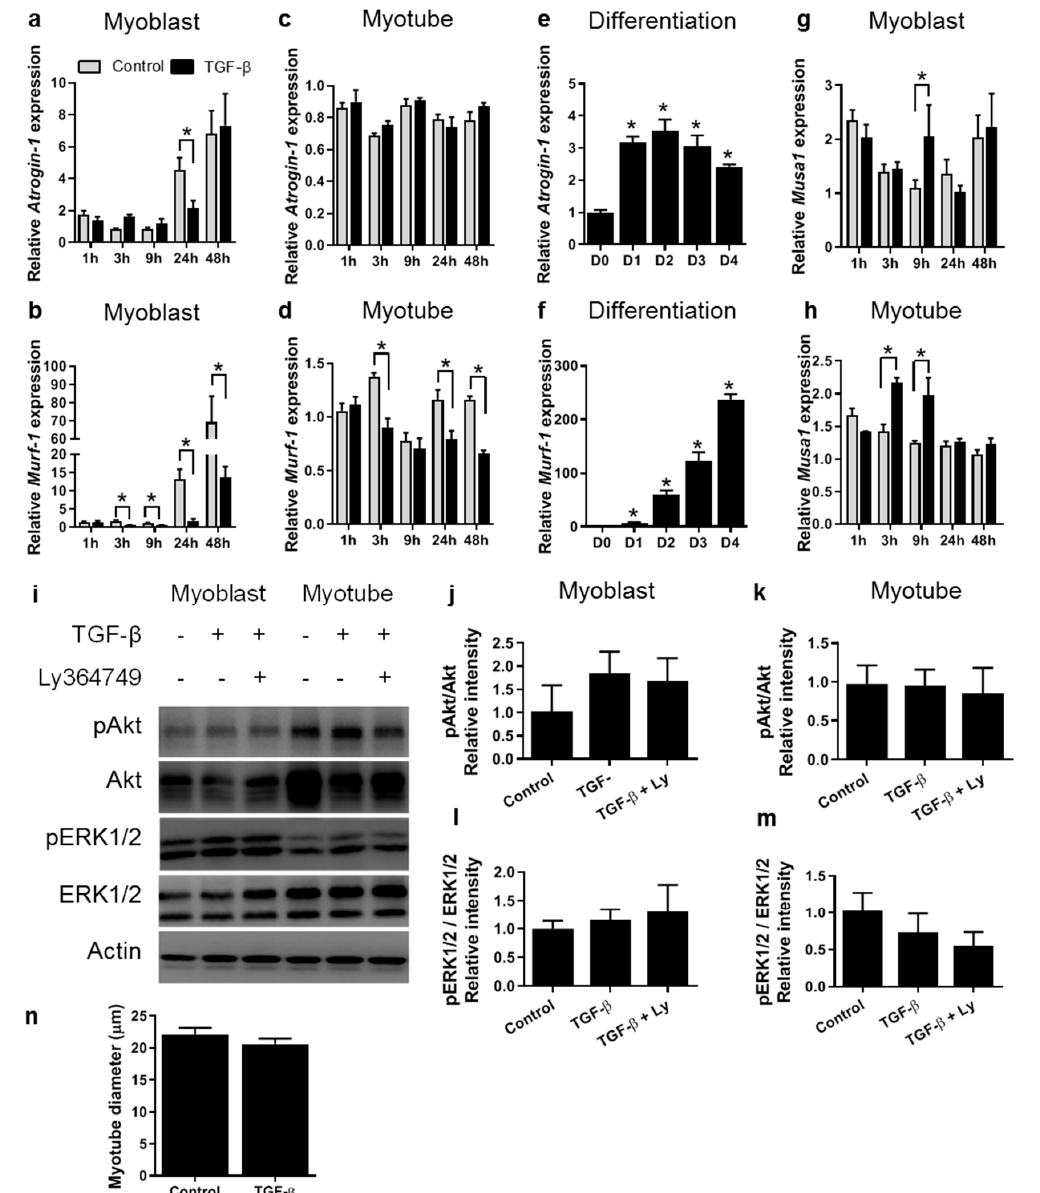
Figure 3. TGF- β does not a ff ect myotube size. ( a , b ) In myoblasts, relative expression levels of Atrogin-1 ( a ) and Murf-1 ( b ) were inhibited by TGF- β . ( c , d ) In myotubes, Atrogin-1 ( c ) expression was una ff ected by TGF- β , while Murf-1 ( d ) expression levels were inhibited after 3, 24 and 48 h. ( e , f ) mRNA expression of Atrogin-1 ( e ) and Murf-1 ( f ) increased during di ff erentiation, where D0 is the start of di ff erentiation and D1, 2, 3 and 4 are days 1 to 4 of di ff erentiation. ( g , h ) In both myoblasts ( g ) and myotubes ( h ), TGF- β transiently increased Musa1 expression levels. Gapdh served as housekeeping gene. Data were normalized to values of control cells at 0 h; * indicates significant di ff erence at p < 0.05; n = 3 experiments per condition ( a – h ). ( i , j ) Western blot quantification of Akt phosphorylation in myoblasts, ( k ) Akt phosphorylation in myotubes, ( l ) ERK1 / 2 phosphorylation in myoblasts, ( m ) ERK1 / 2 phosphorylation in myotubes. Pan actin served as loading control. Phosphorylation levels are displayed as relative intensity of phospho / total protein. Data were normalized to values of the control condition. Error bars indicate standard error of the mean; n = 4 experiments per condition. n After 3 days of TGF- β treatment, the myotube diameters displayed in Figure 1a were not significantly di ff erent from those of control condition. n = 80 per experimental condition.